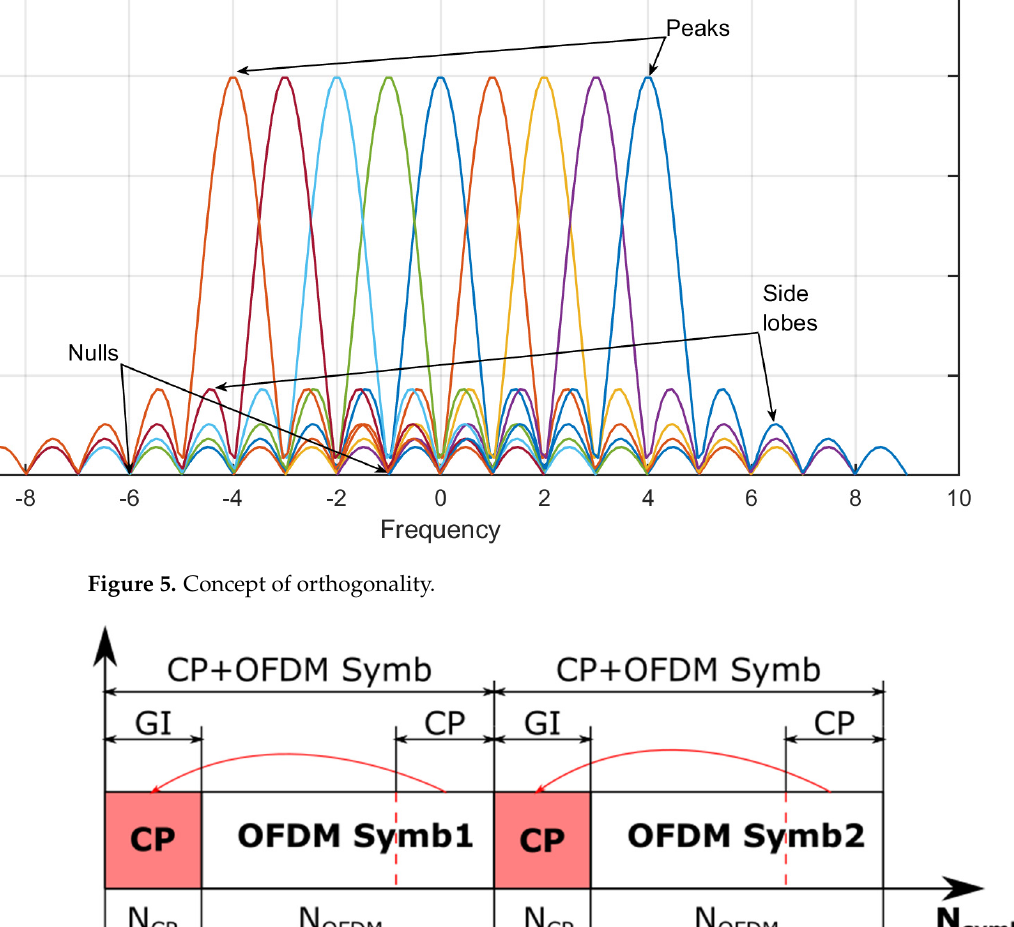
Figure 6. Guard interval (cyclic prefix) insertion.